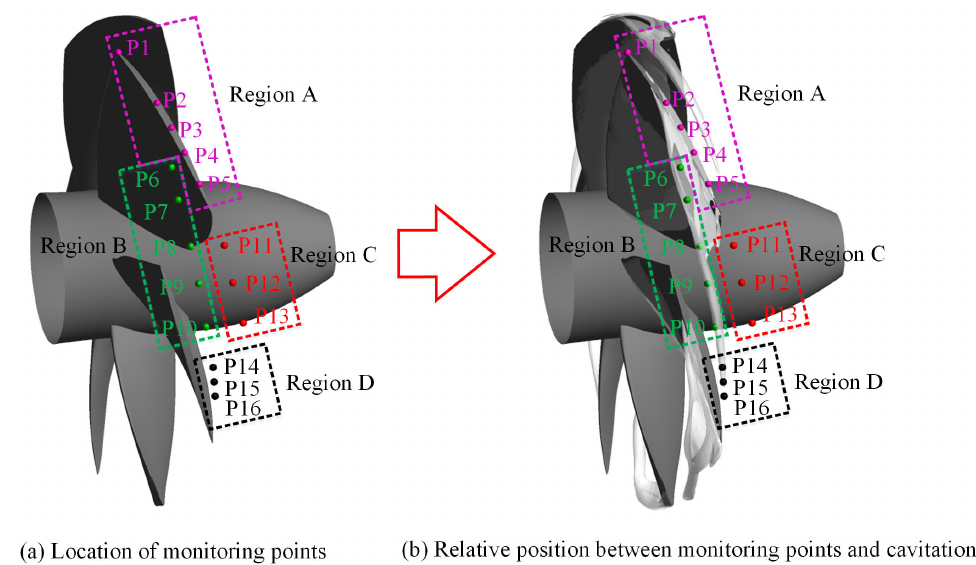
Figure 6. Sketch of the rotor geometries and the positions of the monitoring points. The distributions of LES errors have some differences with the standard